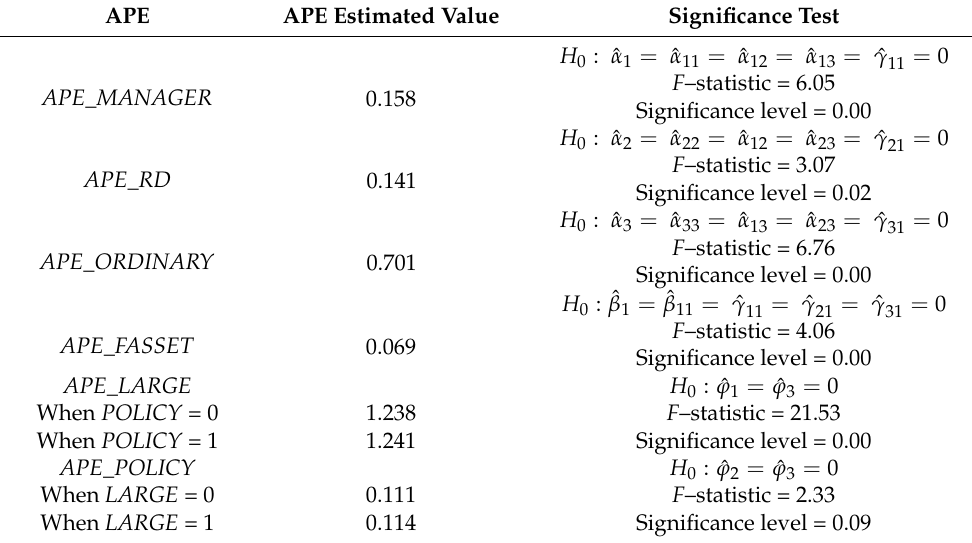
Table 6. APE of human resources, FASSET , LARGE , and POLICY on revenue. APE APE Estimated Value Significance